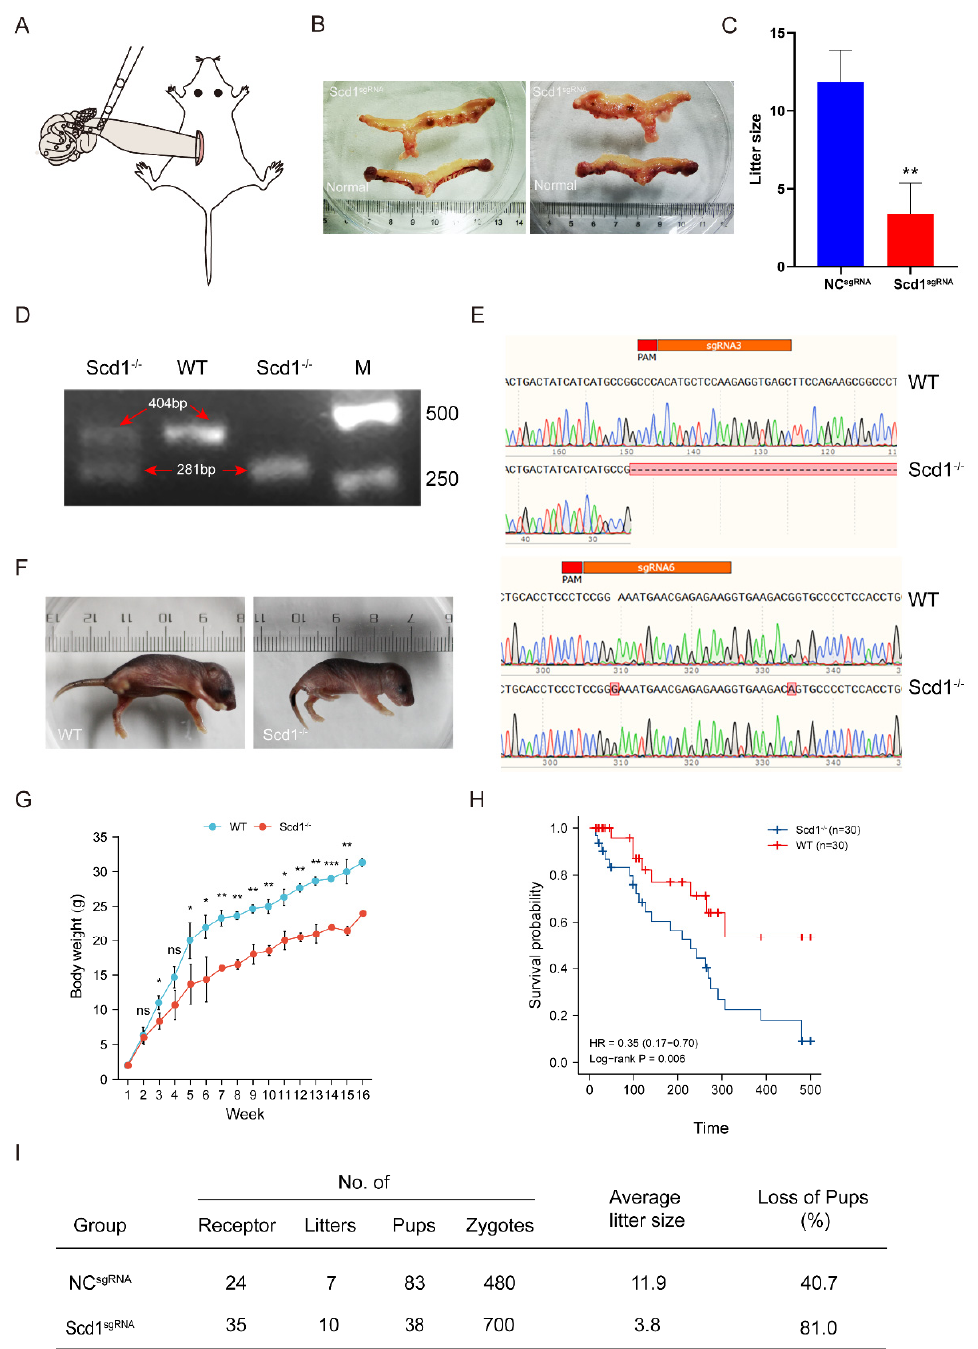
Figure 2. Scd1 deficiency causes embryonic development arrest. ( A ): The diagram of embryo transplantation. ( B ): The uterus of not delivered mice that was transplanted with Scd1 sgRNA embryos at day 22 of gestation. ( C ): The litter size of mice transplanted with NC sgRNA and Scd1 sgRNA embryos. ( D ): Gel analysis of wild type (WT) and Scd1 knockout mice. ( E ): The gene sequences of the WT and Scd1 − / − mice which has 123 bp deletion on the Exon1 and 1 bp insertion on the Exon2. ( F ): Body size of WT and Scd1 − / − mice at day 5 after born. ( G ): Body weight of mice for 16 consecutive weeks in WT and Scd1 − / − group. ( H ): The comparation of Survival curve of Scd1 − / − mice and WT mice. The Log-rank test was used for the statistical analysis. p = 0.006. ( I ): The data of embryo loss after transplantation. * p < 0.05; ** p < 0.01; *** p < 0.001, ns: not